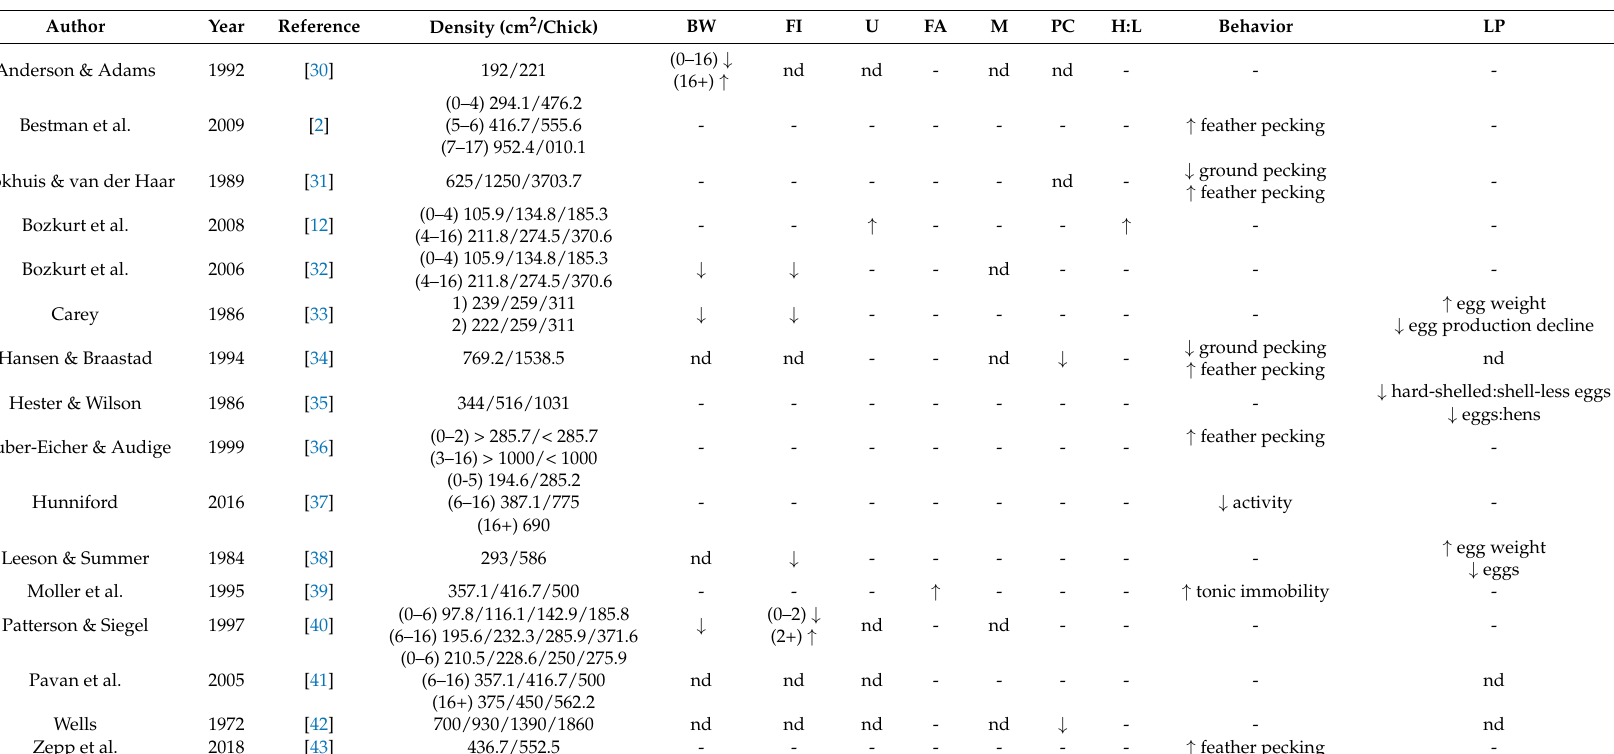
Table 1. Literature overview research on effects of stocking densities during the rearing period on the laying hen. Density is expressed in cm 2 per chick. Per parameter is depicted if the study found an increase, decrease, or no difference (nd) with increasing stocking densities. If the study did not consider the specific parameter, it is designated with ‘-‘. The parameters considered are: body weight (BW), food intake (FI), uniformity of physique (U), fluctuating asymmetries (FA), mortality (M), plumage condition (PC), heterophil:lymphocyte (H:L) ratio, behavior, laying performance